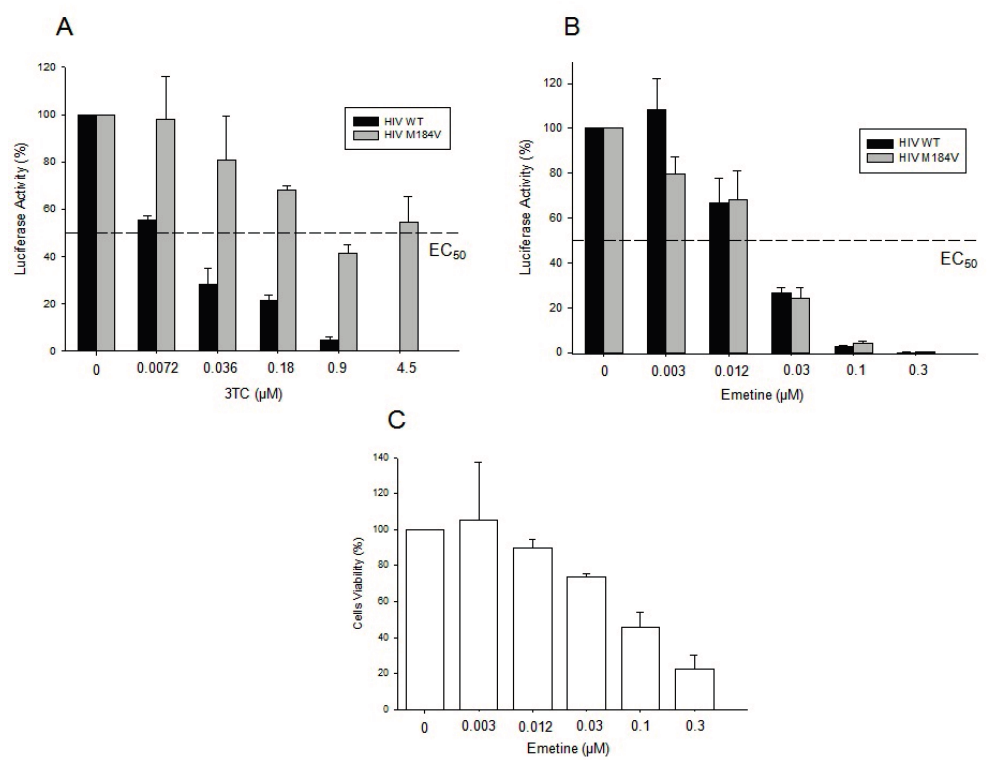
Figure 4. Emetine inhibits HIV wild type and HIV M184V infectivity in PBMCs. Peripheral blood mononuclear cells were isolated from HIV-negative blood donors and infected with HIV WT or HIV M184V and seeded in the presence of an antiretroviral. Viruses' infectivity were evaluated through luciferase activity from PBMCs lysates 96 h post-infection. ( A ) Resistance profile of HIV WT and HIV M184V in PBMCs in the presence of 3TC; ( B ) Phenotypic assays of HIV viruses (WT and M181V) with emetine; ( C ) Cytotoxicity effects of emetine in PBMCs. Peripheral blood mononuclear cells were incubated with increasing concentrations of emetine, followed by propidium iodide staining and flow cytometry analysis. All the results represent the means calculated from three independent experiments with triplicates and all the results are expressed as percentage of untreated cells. The EC 50 representative value is shown in the